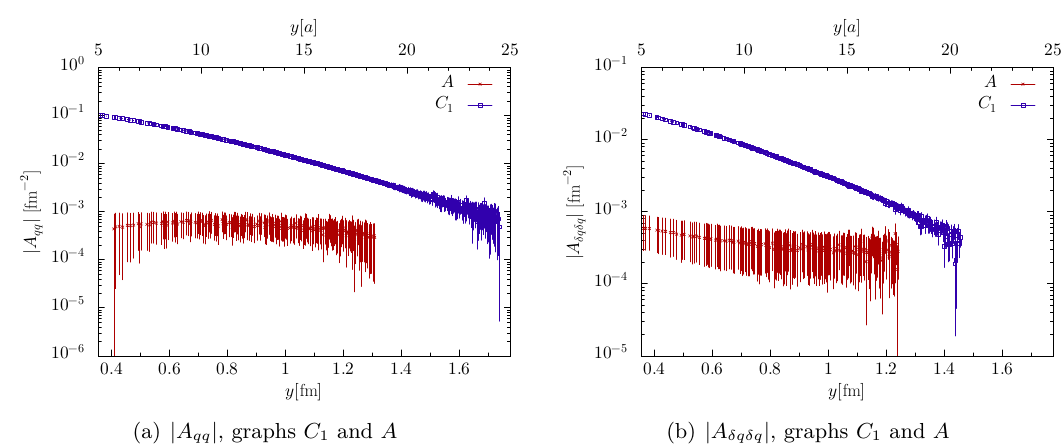
Figure 16 . Comparison of graphs A and C 1 for strange quarks. Here and in subsequent figures with a logarithmic scale, we stop showing data for individual quark masses at a value of y beyond which the error bars become so large that they would obscure the